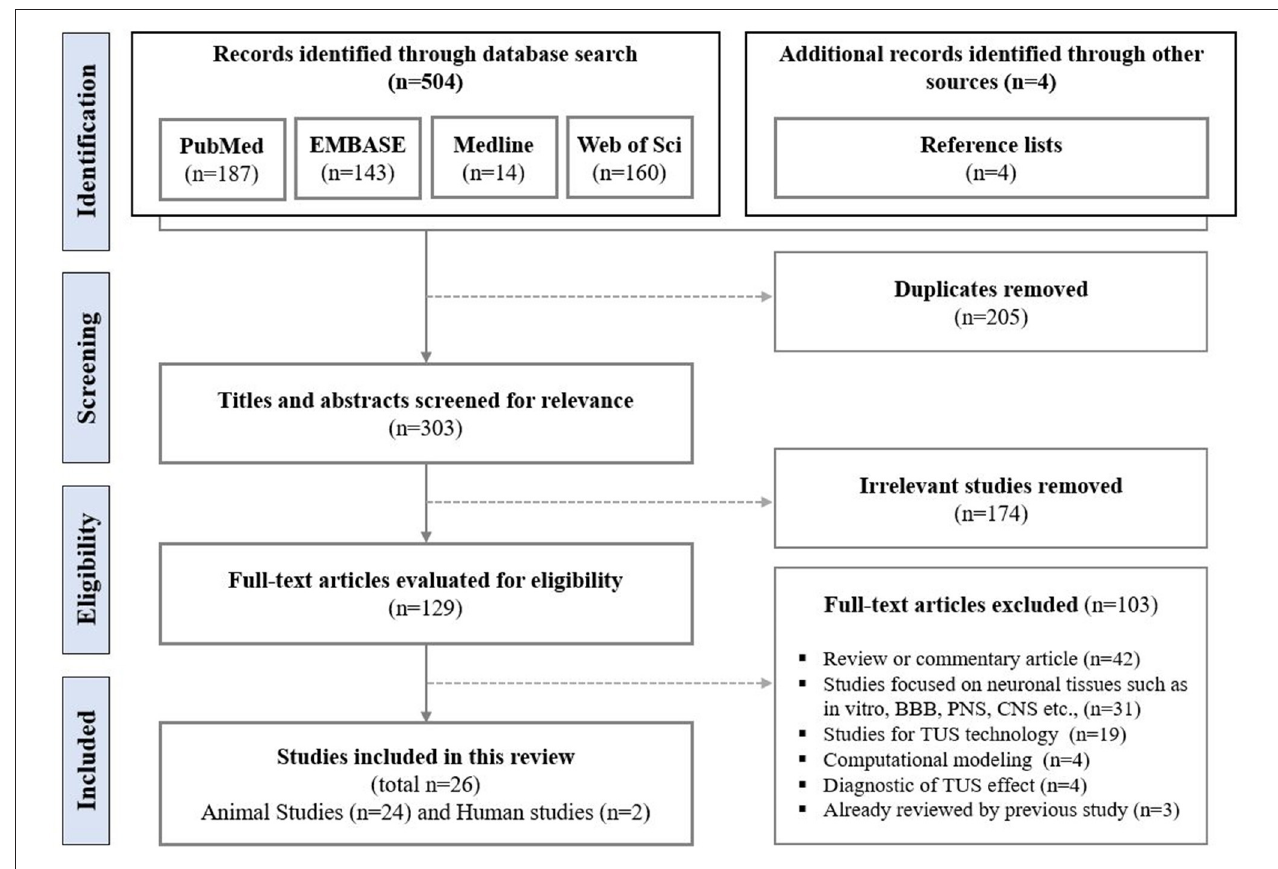
FIGURE 1 | Flowchart of literature search.